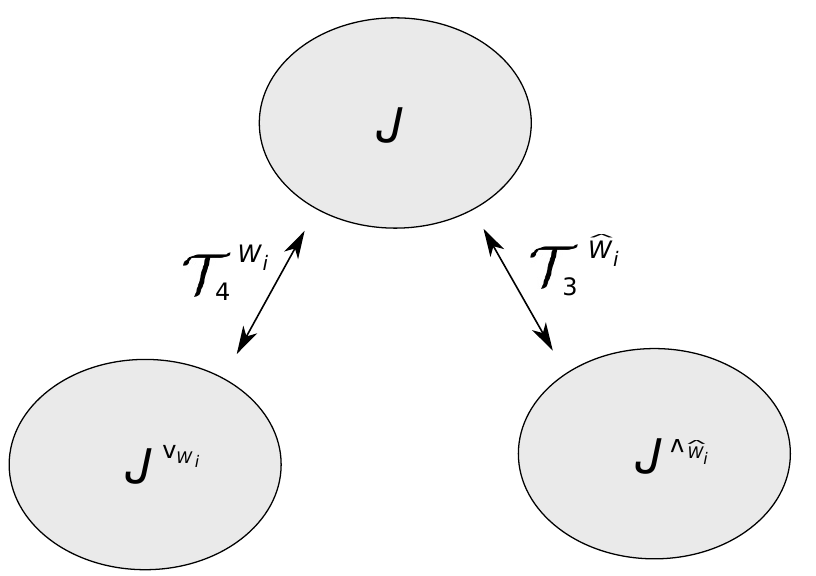
Figure 2 . Network of generalized G 2 mirror symmetry maps obtained from T-dualities. the N = 8 one preserving only a common N = 2 supersymmetry subalgebra. In